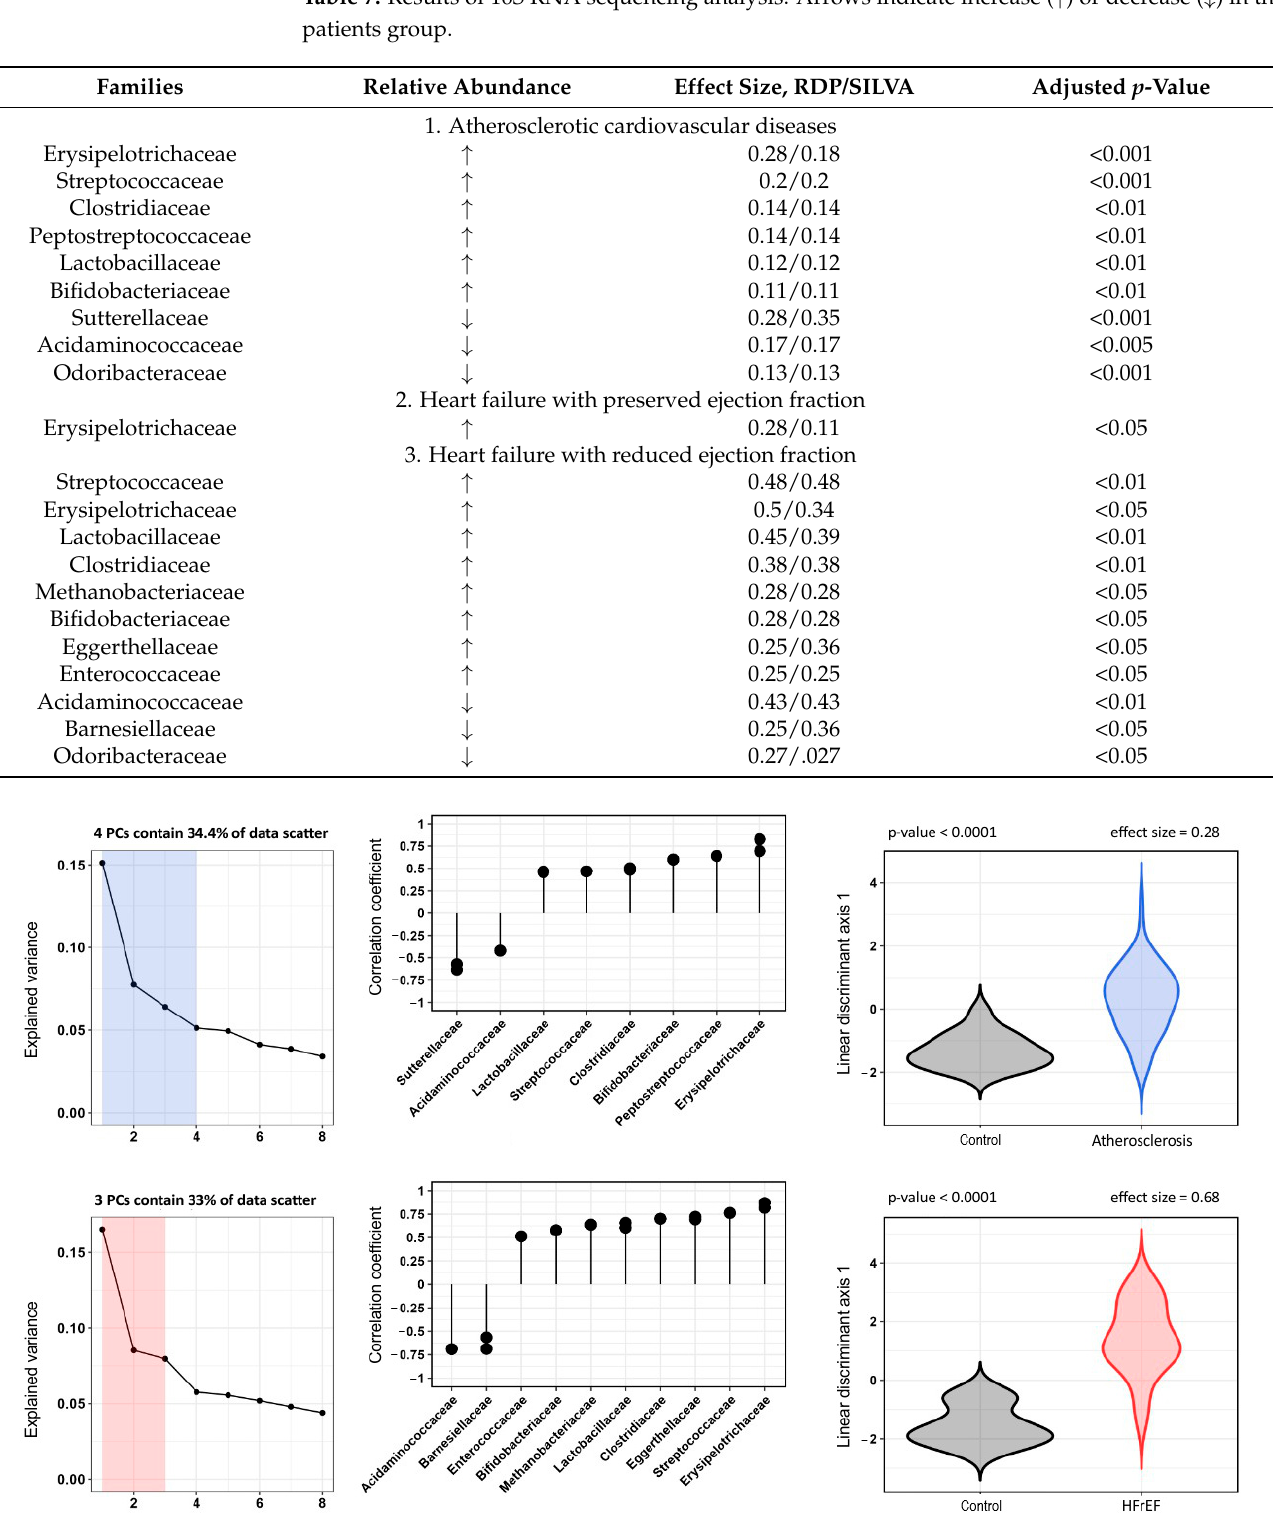
Figure 4. Results of PCA data processing (metagenome), the established correlation between the best discriminant axis and initial indicators, the distribution of the observed group values across the best discriminant axis. The top row of graphs is a comparison of patients of the control group and patients with atherosclerosis, the bottom row of graphs is a comparison of patients of the control group and patients with HFrEF patients.